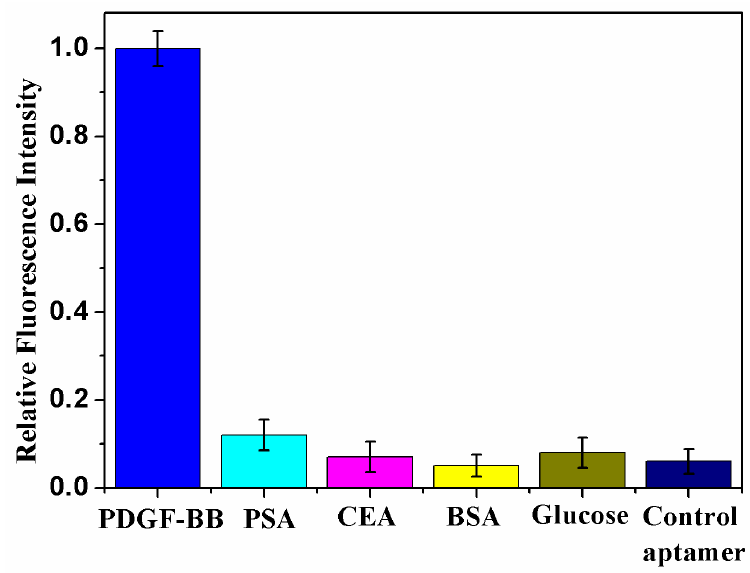
Figure 4. The detection specificity of the proposed aptamer sensor. Prostate-specific antigen (PSA), carcino-embyonic antigen (CEA), albumin from bovine serum (BSA), glucose, and the control aptamer were used to evaluate the detection specificity of the present biosensing system. The concentration of PDGF-BB